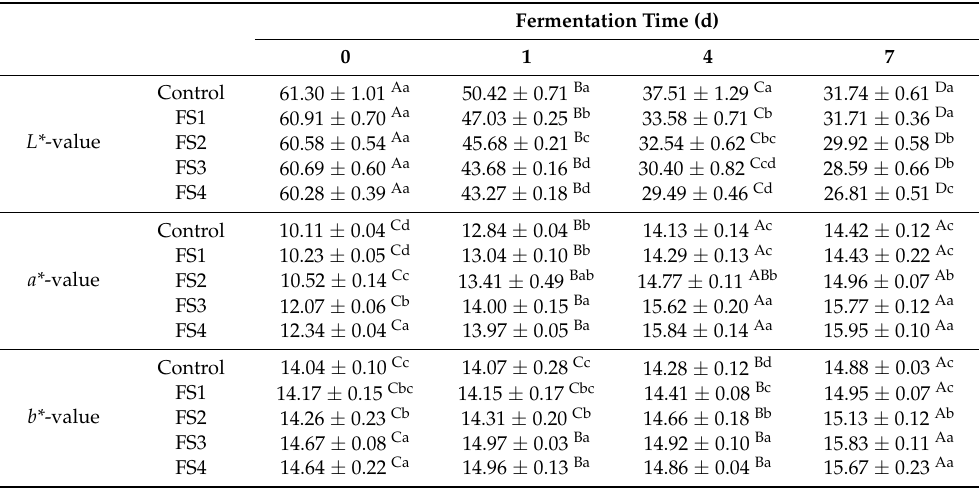
Table 4. Changes in colour values ( L* , a* and b* ) of Harbin dry sausages with different replace- ment levels of CFS during fermentation.